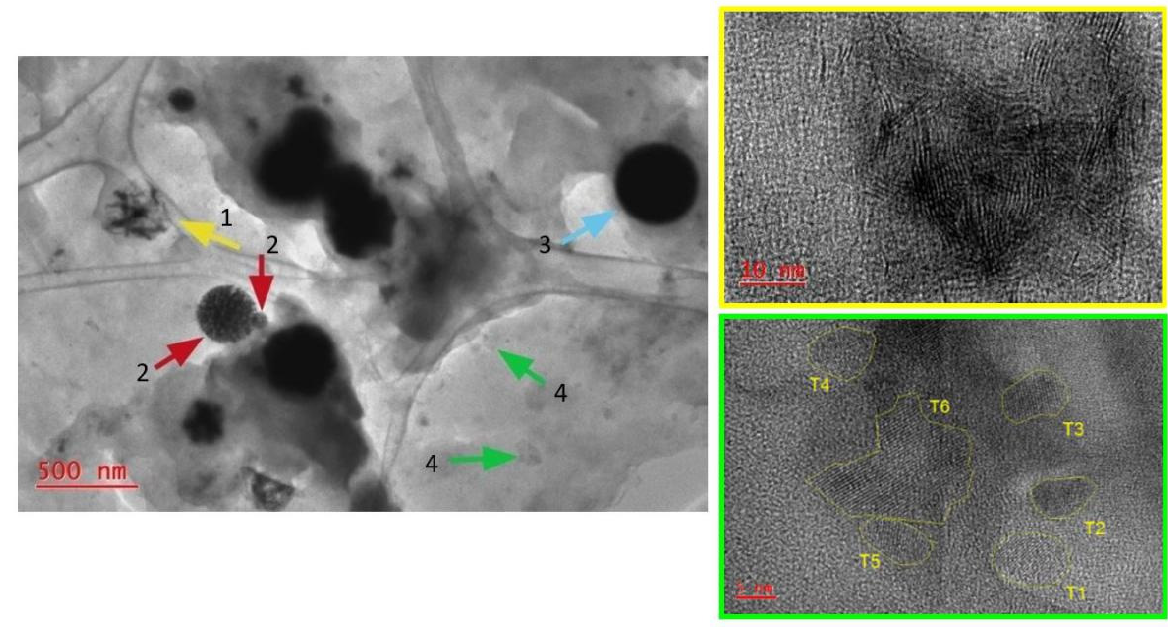
Figure 1. TEM images for TI-sample from test #2 (C(Mo) = 0.05%wt.).